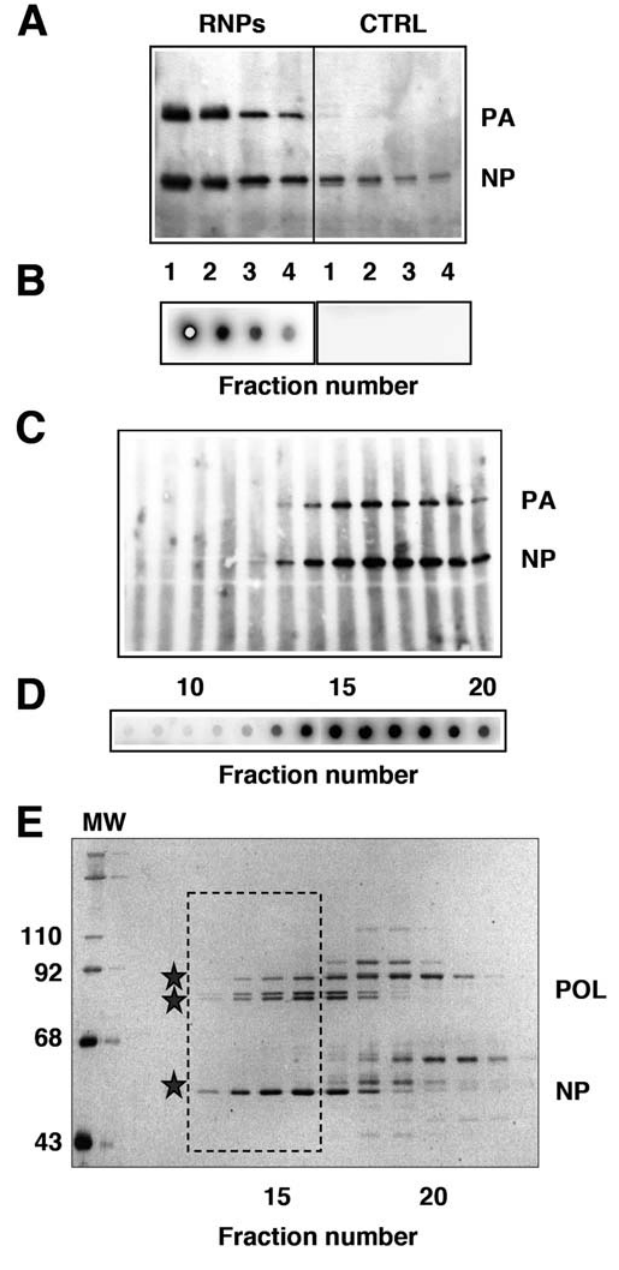
Figure 1. Generation and purification of a model recombinant RNP. (A) Recombinant RNPs containing a 248 nt long genomic RNA were generated and amplified in vivo as indicated under Materials and Methods. The RNPs containing a His-tagged PB2 protein (RNPs) were purified by chromatography on Ni-NTA-agarose and the eluted fractions were analysed by Western-blot using anti-PA and anti-NP antibodies. As control, untagged RNPs were generated and purified in parallel (CTRL). (B) The eluted fractions shown in (A) were assayed by in vitro transcription. (C–E) The eluted RNPs were separated on a Sephacryl S300 column and the fractions were analysed again by Western-blot (C) and in vitro transcription as above (D), as well as by silver-staining (E). The position of molecular weight markers (MW) is indicated to the left. The stars indicate the position of the polymerase subunits (POL) and the nucleoprotein (NP). The frame indicates the fractions chosen for electron microscopy analyses.